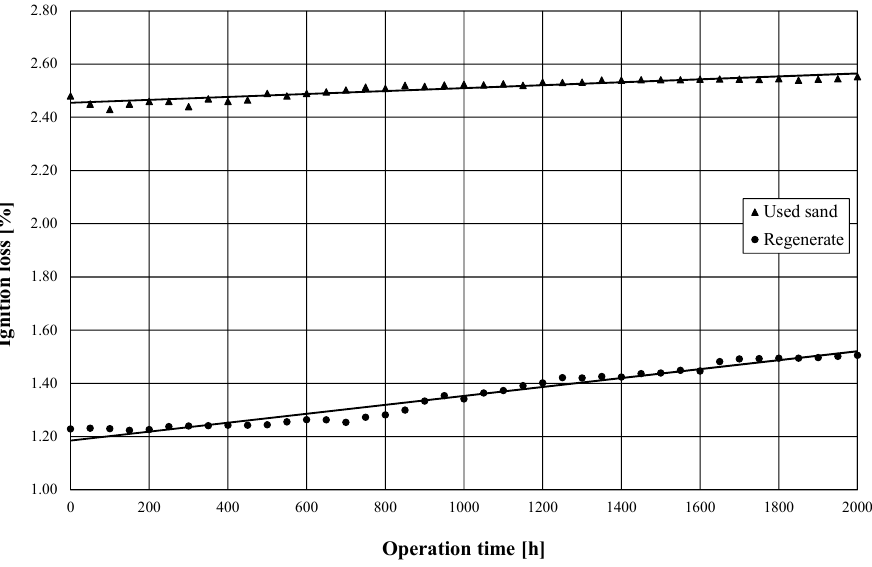
Figure 2. Ignition loss of used sand and regenerate as a function of USR-I device operation time, measurement at constant supply pressure set as p = 2.4 bar.